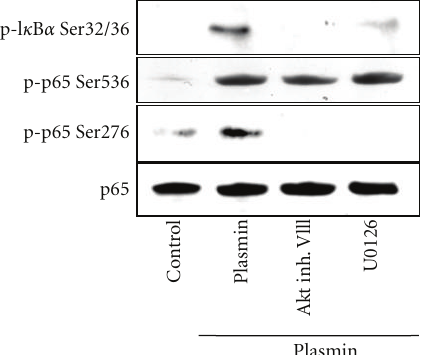
Figure 6: Akt and ERK1/2 activation is indispensable for the plasmin-induced activation of NF- κ B. Analysis of I κ B α and p65 phosphorylation. Dendritic cells were pretreated with the Akt inhibitor VIII or the MEK/ERK1/2 inhibitor U0126 (each at 1 μ M) for 15 min and then stimulated with plasmin (0.143 CTAU/mL) for 40min. Dendritic cells were collected, lysed, and subjected to western blot analysis with antibodies against the phosphorylated forms of I κ B α (Ser32/Ser36) and p65 (Ser276 and Ser536). Staining with p65 antibody-loading control. Results are representative of 3 independent